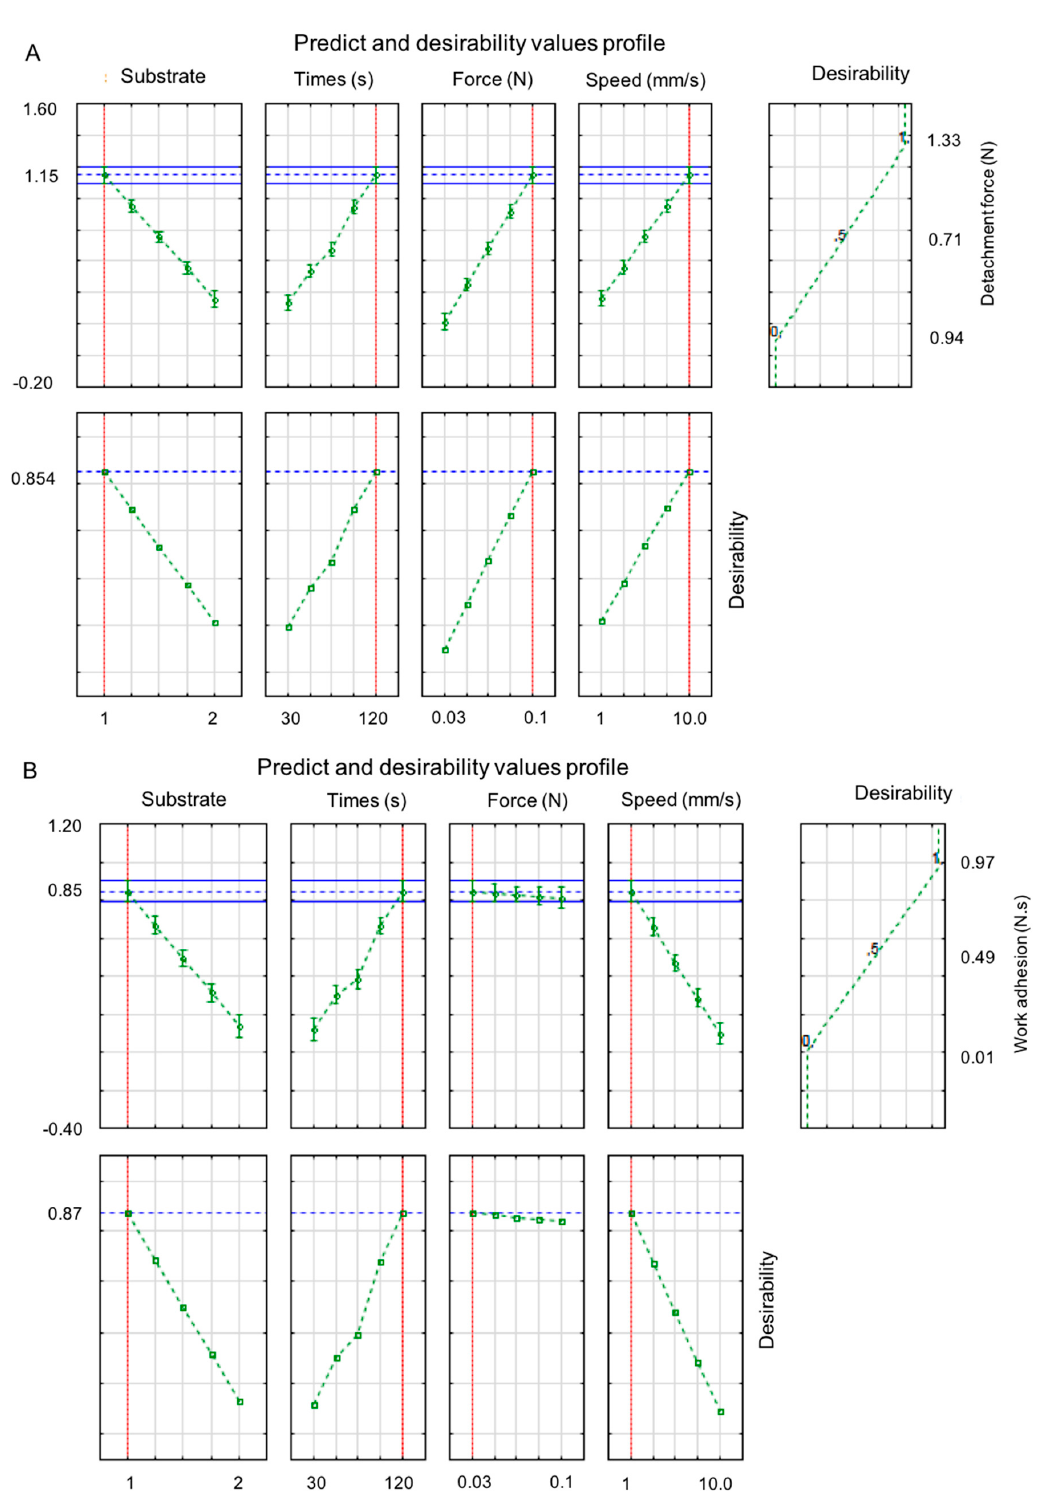
Figure 5. Profile of prediction and desirability values of the detachment force ( A ) and work adhesion ( B ) related to the substrate, time (s), applied force (N), and speed of probe ascent (mm/s). About the W adh (Figure 5B), the desirability was at 92% of the maximum experimental value